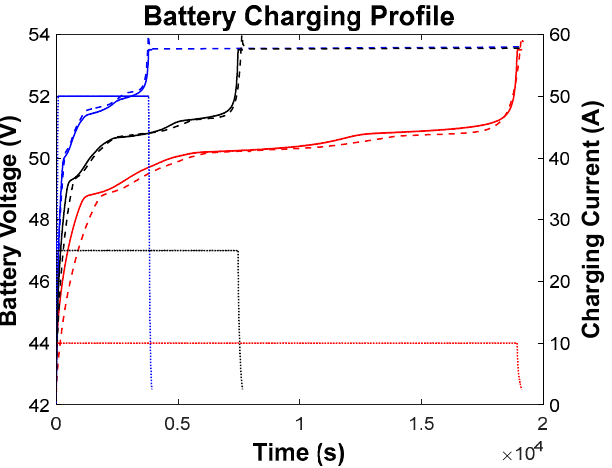
Figure 13. Charging profiles at 10, 25, and 50 A. Solid lines: Experimental battery voltage. Dashed lines: Simulation result. Dot lines: Charging current.